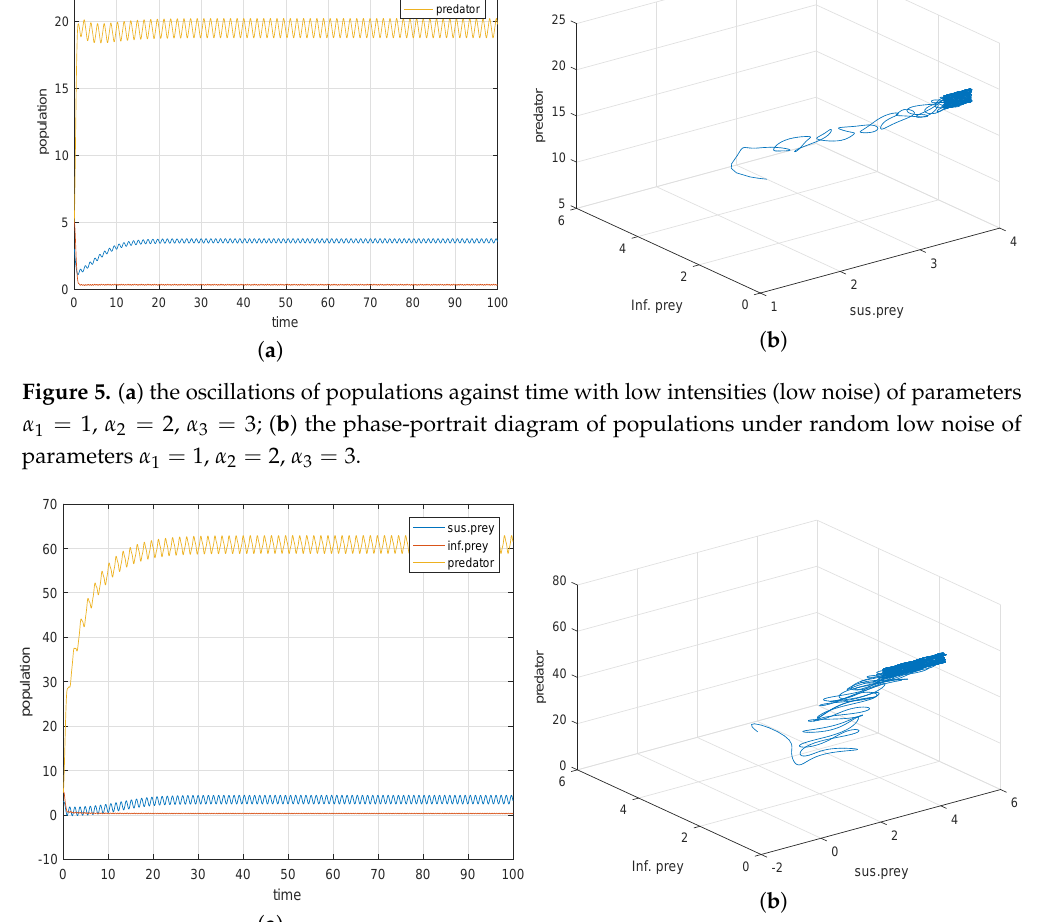
Figure 6(a)represents the variations of populations against time with the parameters α 1 = 6 ,α 2 = 8 ,α 3 = 8 . Figure 6(b) represents the phase portrait diagram of prey and predator under random noise with the parameters α 1 = 6 ,α 2 = 8 ,α 3 = 8 . Figure 6. ( a ) the oscillations of populations against time with medium intensities (medium noise) of parameters α 1 = 6, α 2 = 8, α 3 = 8; ( b ) the phase-portrait diagram of populations under random medium noise of parameters α 1 = 6, α 2 = 8, α 3 = 8.